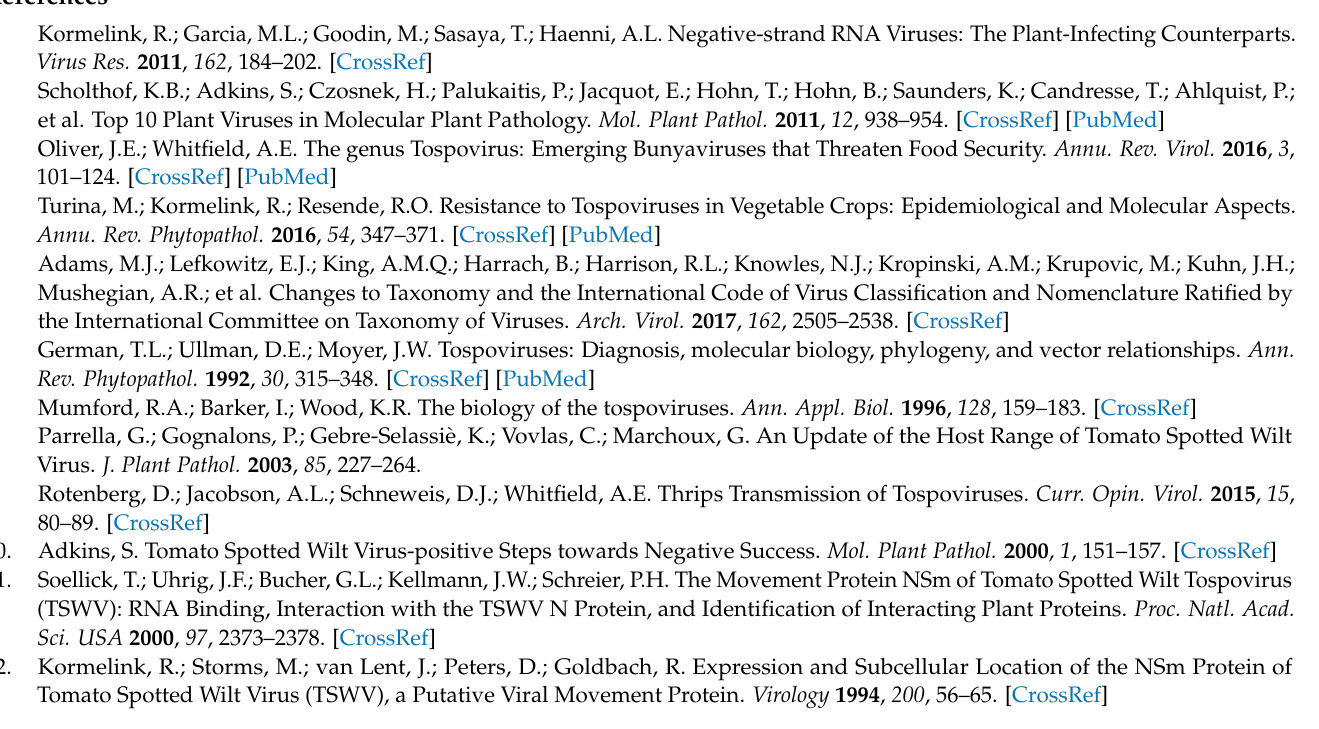
phenotype, Figure S2: Two transgenic lines of NbTMP14 overexpression plants, Table S1: The primers used in this